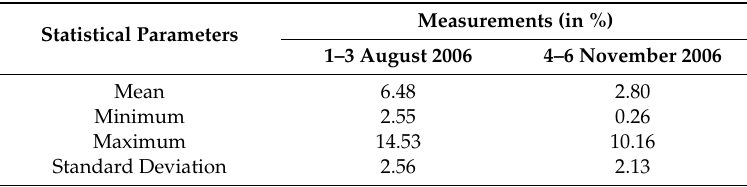
Table 1. Statistics of in situ soil moisture measurements.